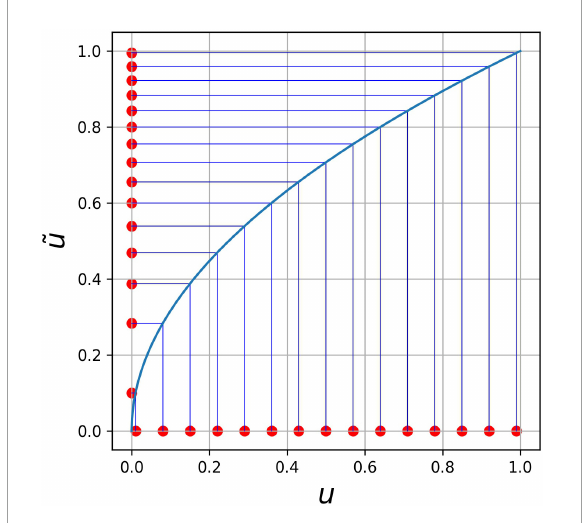
FIGURE4 Transformation of random threshold u from uniform distribution into threshold e